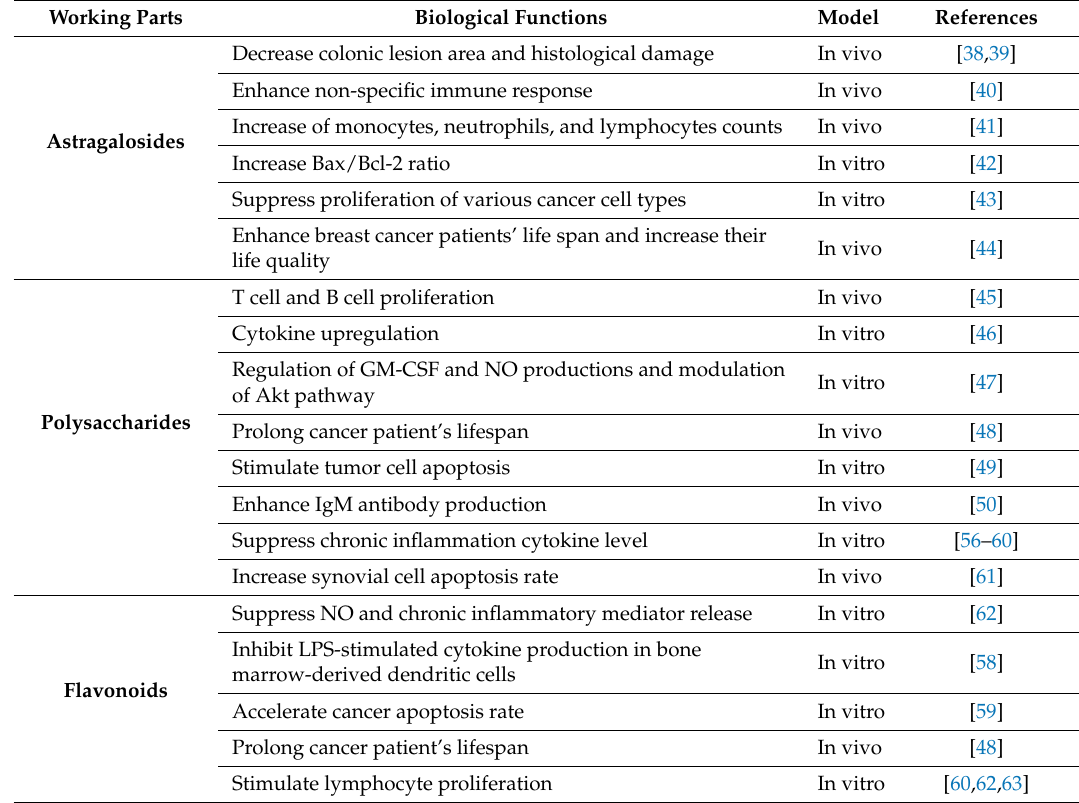
Table 2. The immunomodulatory functions of AR and its major constituents. Working